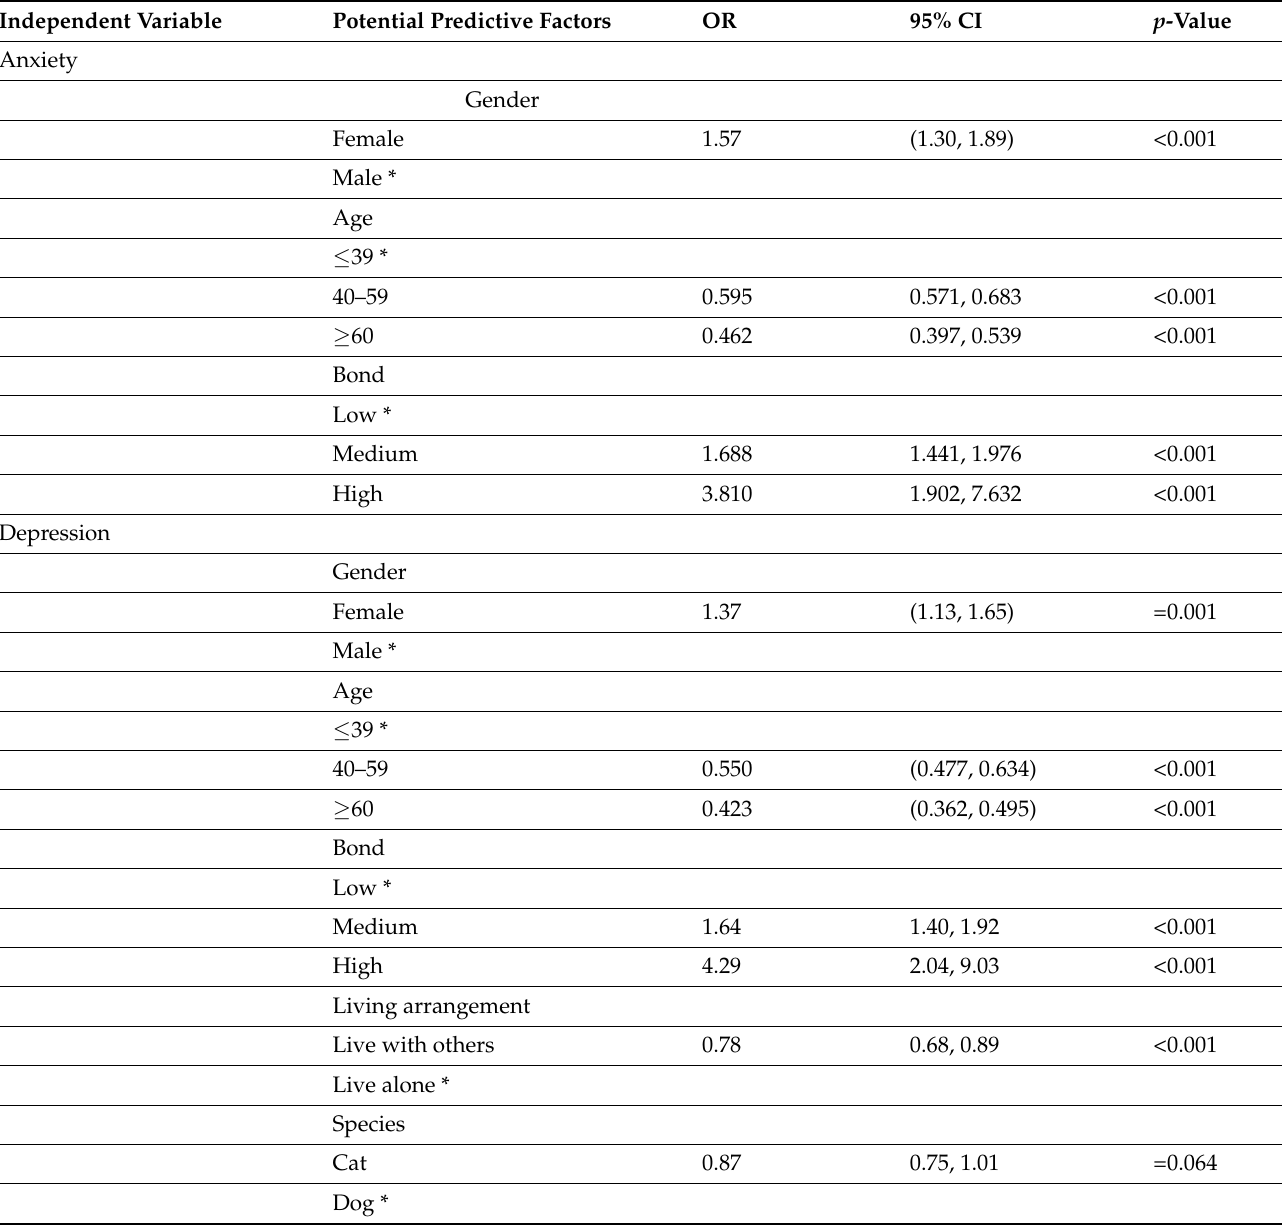
Table 6. Binary regression for negative COVID-19 related